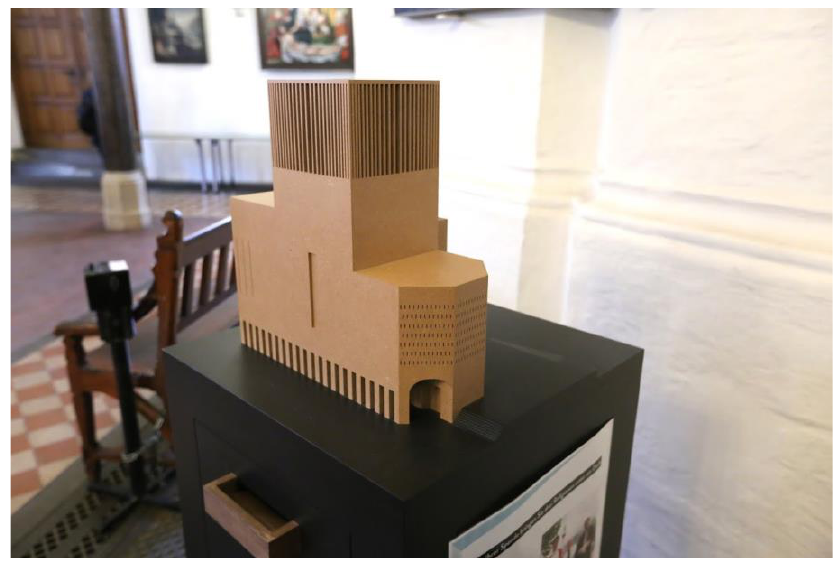
Figure 10. Model of the House of One, Berlin. Figure 9. Model of the House of One,